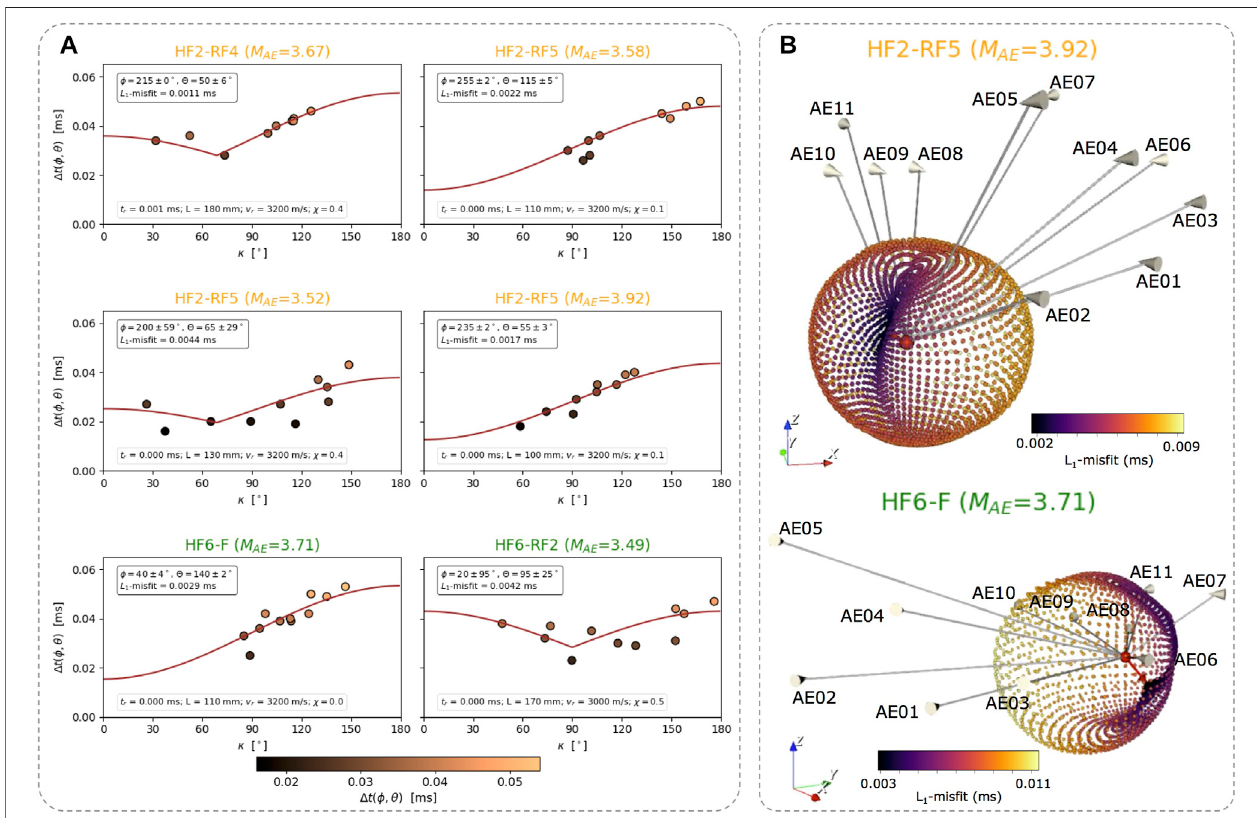
FIGURE 3 | Rupture directivity analysis in 3D for the target AE events recorded during HF2 and HF6 in the Äspö HRL. (A) For each target AE event, we show the apparent durations measurements (dots) along with the theoretical prediction (brown line) for the inverted model using a full grid search approach (labels indicate the solution of each parameter). (B) L1-mis fi t for each tested direction (dots) for the largest AE events recorded during HF2 (top) and HF6 (bottom) . The directivity vector solution with minimum L1-mis fi t (red arrow) and the station vectors (gray lines) for each AE sensor are also shown. Red dots indicate the origin of the coordinate system. The radius for each tested direction is also scaled according to the L1-mis fi t values as in the